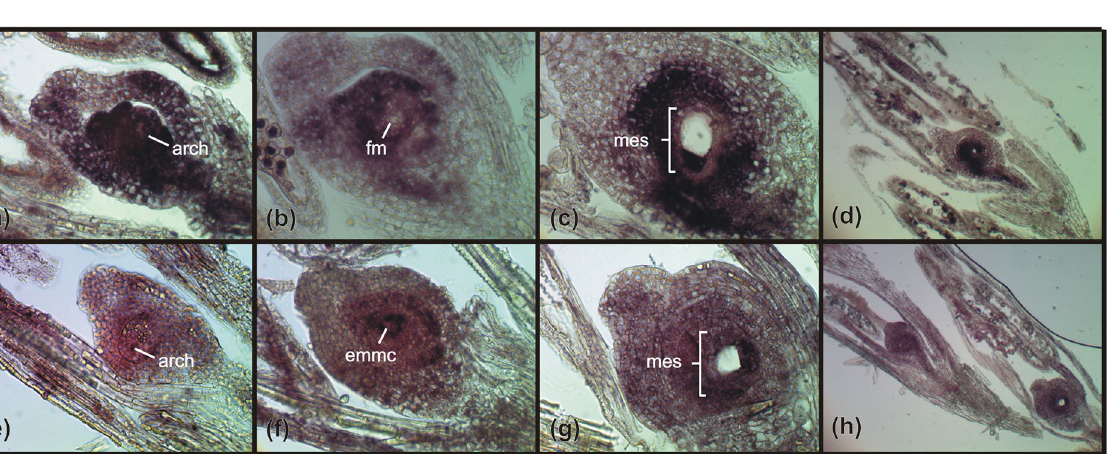
Figure 4. mRNA in situ hybridization of EcAGO104 during sexual and apomictic reproduction in E. curvula . ( a–d ) Ovaries from the sexual genotype hybridized with an EcAGO104 antisense probe showing: ( a ) an ovule primordium with strong, patchy signal in the nucellus and integuments and no signal in the archesporial cell; ( b ) signal restricted to the functional megaspore in a tetrad; ( c ) a mature embryo sac with all cells positive and no signal in the surrounding nucellar cells, and; ( d ) a general view of reproductive organs. ( e–h ) Ovaries from the apomictic genotype hybridized with an EcAGO104 antisense probe showing: ( e ) an apomictic ovule primordium with a strong signal detected in the archesporial cell only; ( f ) an elongated, unreduced MMC; ( g ) a mature embryo sac, and; ( h ) a general view of reproductive organs. Arch: archespore, dm: degenerated megaspores, fm: functional megaspore, mes: mature embryo sac, emmc: elongated megaspore mother cell.